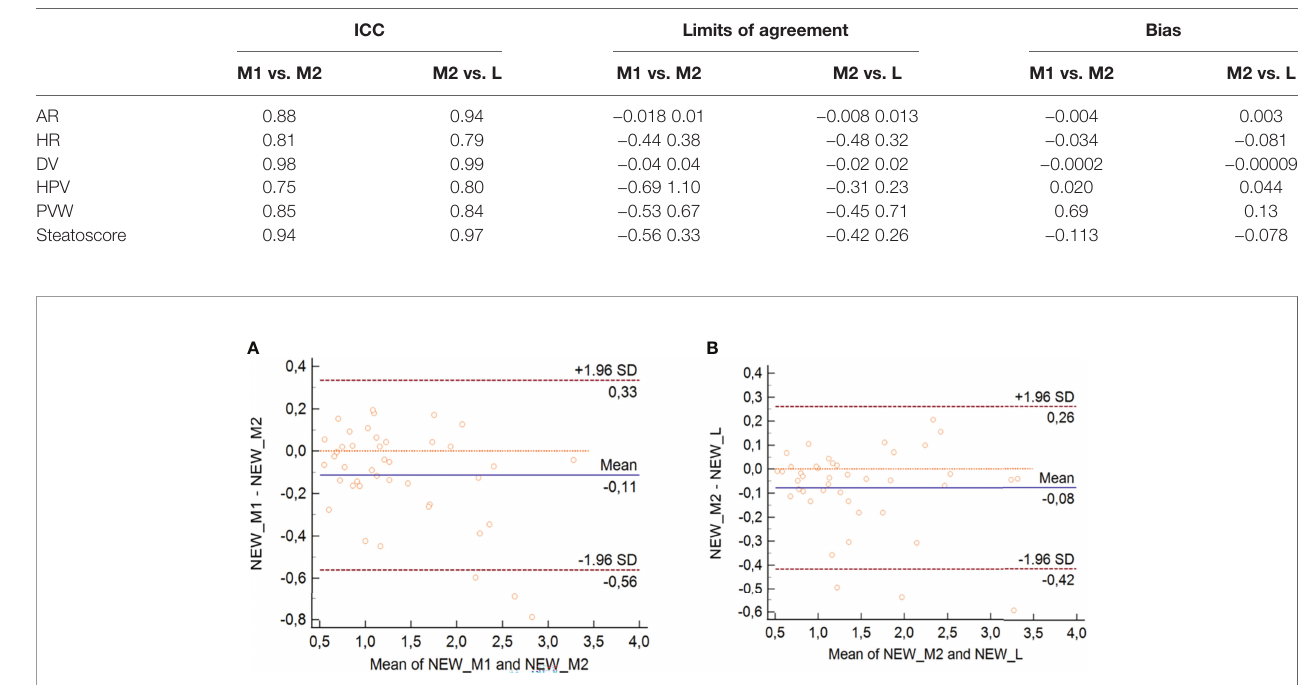
FIGURE 3 | Bland – Altman analysis for intra-operator 1 (A) and inter-operator (B) with SteatoScore